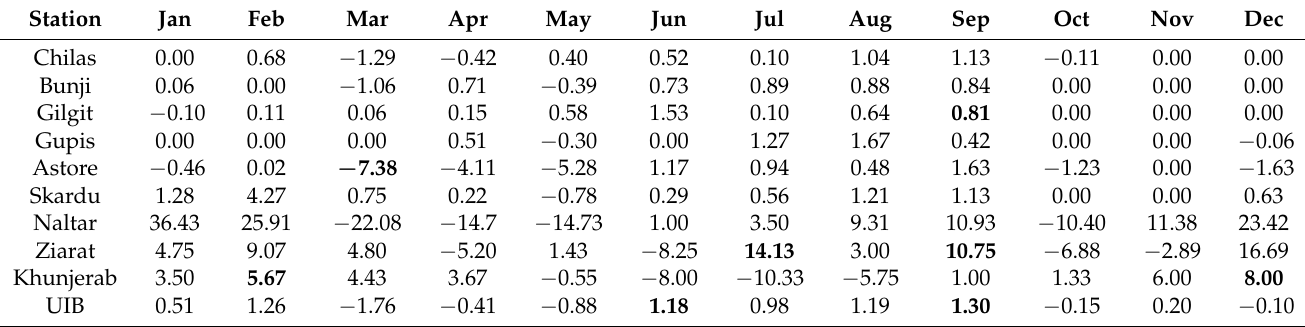
Table 5. Sen’s estimator for monthly precipitation (mm/decade). Bold indicates significant trend at 5% level.